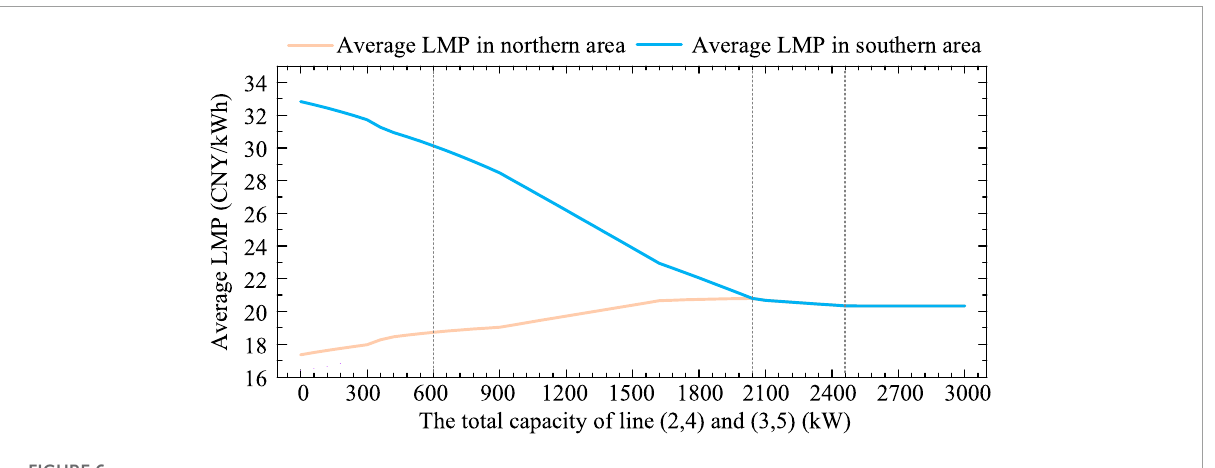
FIGURE 6 LMPs in the opposite area for different values of the total capacity of lines (2.4) and (3.5).